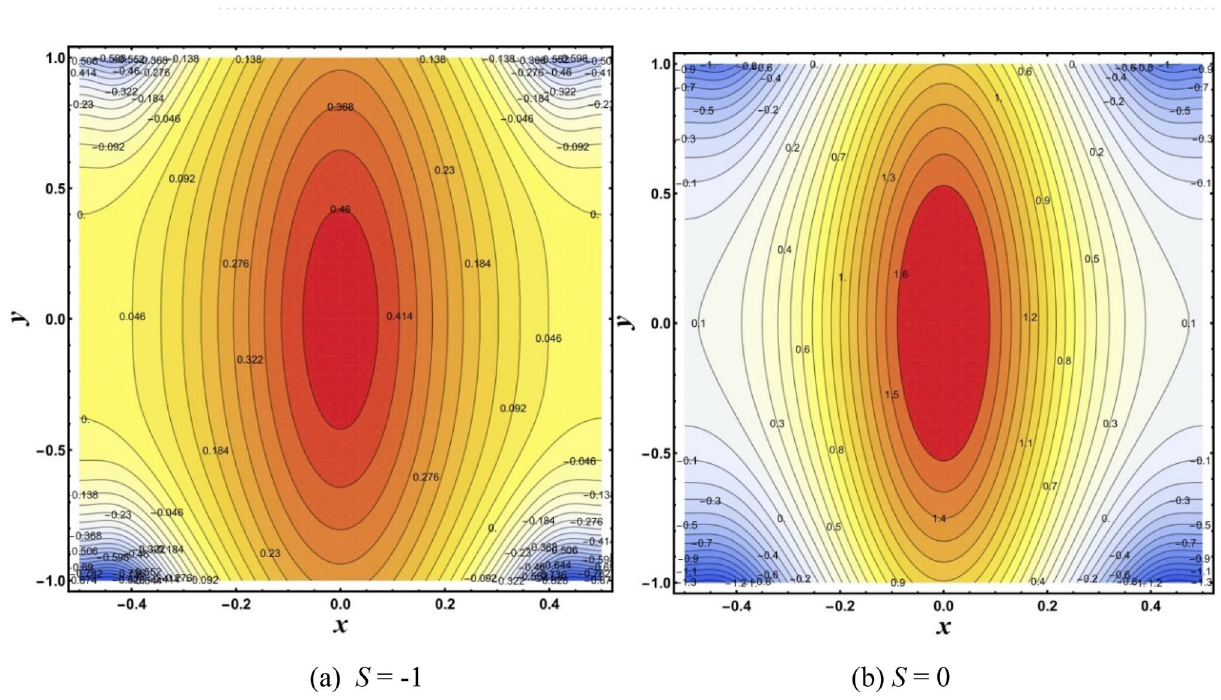
Figure 6. Isotherms for change in S Figure 8a–e are made to evaluate the change in pressure gradient with respect to x across various embedded parameters. Figure 8a shows a reduction in pressure gradient with increasing concen- tration of nanomaterials. The addition of nanomaterials increases the resistance to fluid flow and thus reduces the pressure gradient. A reverse trend is seen in Fig. 8b with the impact of viscosity parameter. From Fig. 8c, pressure gradient decreases by improving electroosmotic parameter. The existence of EDL in charged surfaces abstains the flow, therefore pressure gradient decreases. Figure 8d portrays that pressure gradient develops by improving U hs . The pressure gradient is suppressed by increasing M (see Fig. 8e). The pressure gradient change to increase the Hartmann number is large when M > 1.